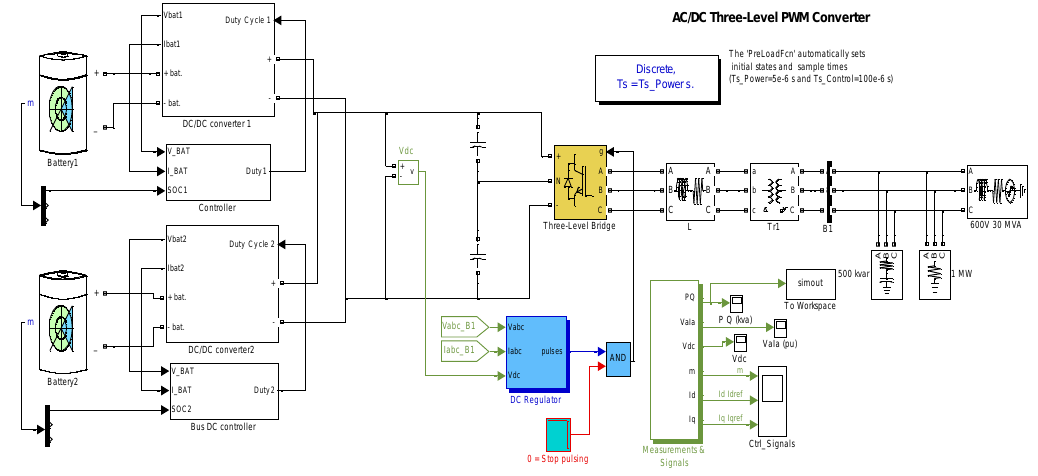
Figure 4. Simulation model of the proposed EV charging station.